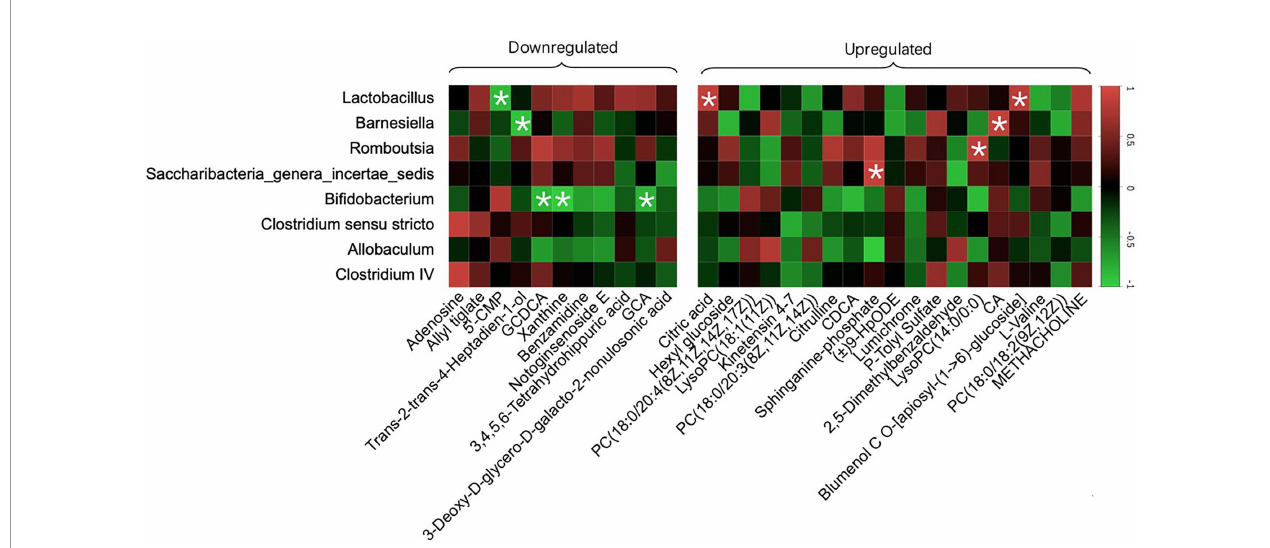
FIGURE 9 | Speci fi c metabolites altered with changes in gut microbiota. The color of each spot in the heat map corresponded to the R value of the Pearson correlation analysis between OTUs of gut microbiota at the genus level and the relative concentration of the metabolites. Spots marked with asterisks (*) represent a signi fi cant correlation with |R| <1 and p-value<0.05. The spots in the left matrix represent the downregulated metabolites in the SPRC group; accordingly, the spots in the right matrix represent the upregulated